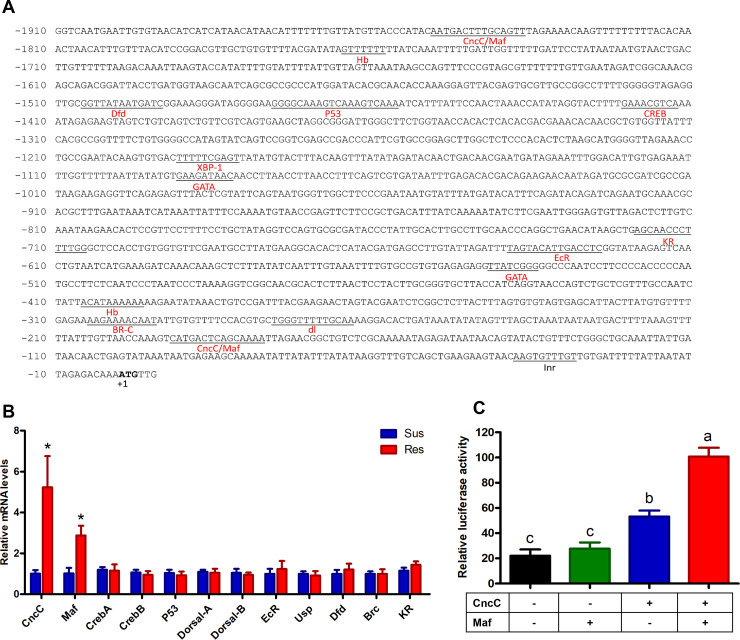
Overexpression of CncC and Maf increases the promoter activity of CYP321A8.(A) Prediction of transcription factor binding sites in a ~2 kb region of the promoter of CYP321A8 gene. Nucleotides are numbered relative to the translation start site (ATG) indicated by +1. The predicted binding sites for transcription factors sites are underlined. The predicted transcription initiation site (Inr) is underlined. (B) Relative expression of transcription factors in the susceptible and resistant strains of S. exigua as determined by RT-qPCR. Error bars display SD. A significant difference (p < 0.05) in expression between the Sus and Res strains is indicated using an asterisk (ANOVA with post-hoc Tukey’s HSD). (C) The Luciferase activity in cells transfected with the reporter construct (the luciferase gene is under the control of CYP321A8 promoter) and CncC or Maf and both CncC and Maf expression constructs. Different letters above the bars indicate significant differences based on ANOVA followed by post-hoc Tukey’s HSD (p < 0.05).